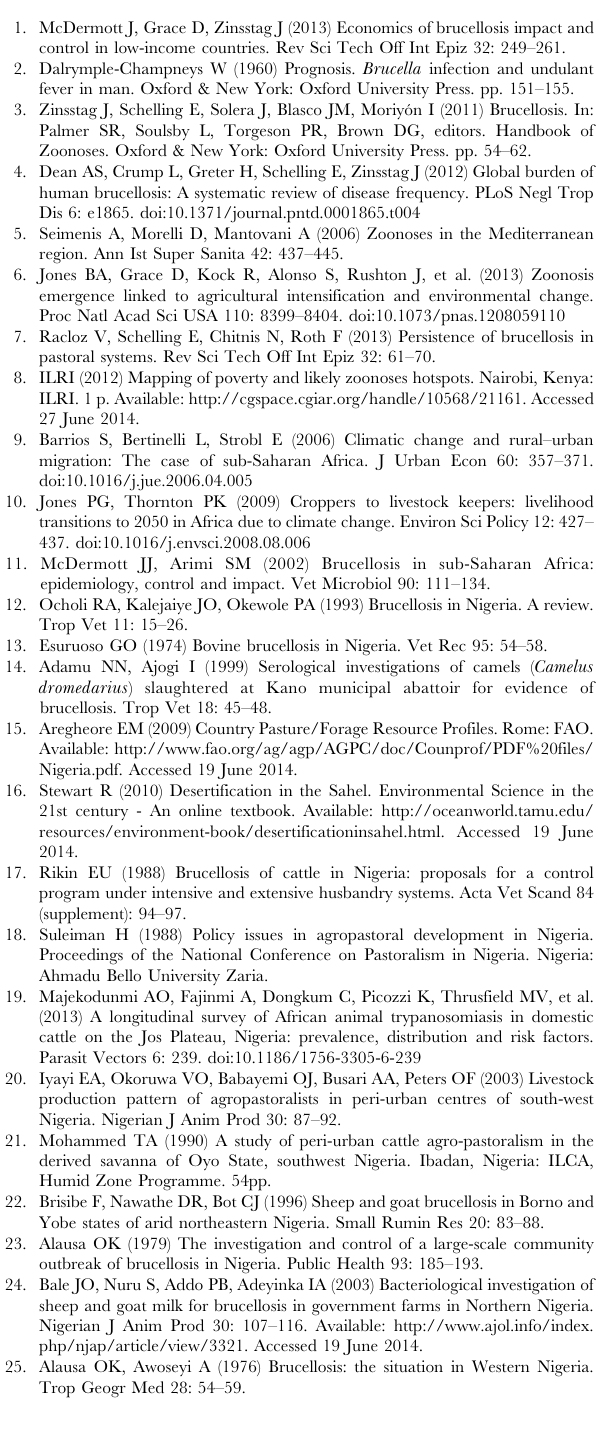
Table S12 Brucellosis serology studies in sheep and goats undertaken in extensive and intensive livestock systems in parallel. Table S13 Brucellosis serology studies in sheep and goats under non-specified livestock systems. Table S14 Brucellosis abattoir serology studies in sheep and goats.